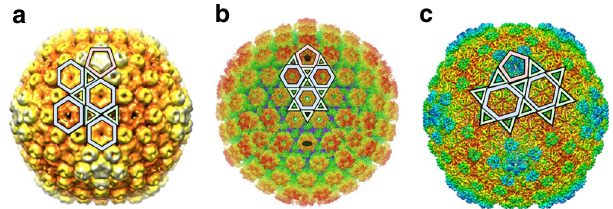
Fig. 3 Viruses within a viral lineage adopting the same icosahedral series. Examples of viruses in the HK97 lineage, demonstrating that different members conform to the same family of icosahedral polyhedra: a Basilisk ( T t ð 3 ; 0 Þ ), b HSV-1 ( T t ð 4 ; 0 Þ ), c phage λ ( T t ð 2 ; 1 Þ ). The building blocks of their polyhedral surface lattices are shown in red (pentagons), blue (hexagons), and green (triangles) superimposed on fi gures adapted from ( a ) 19 , ( b ) 23 and ( c )